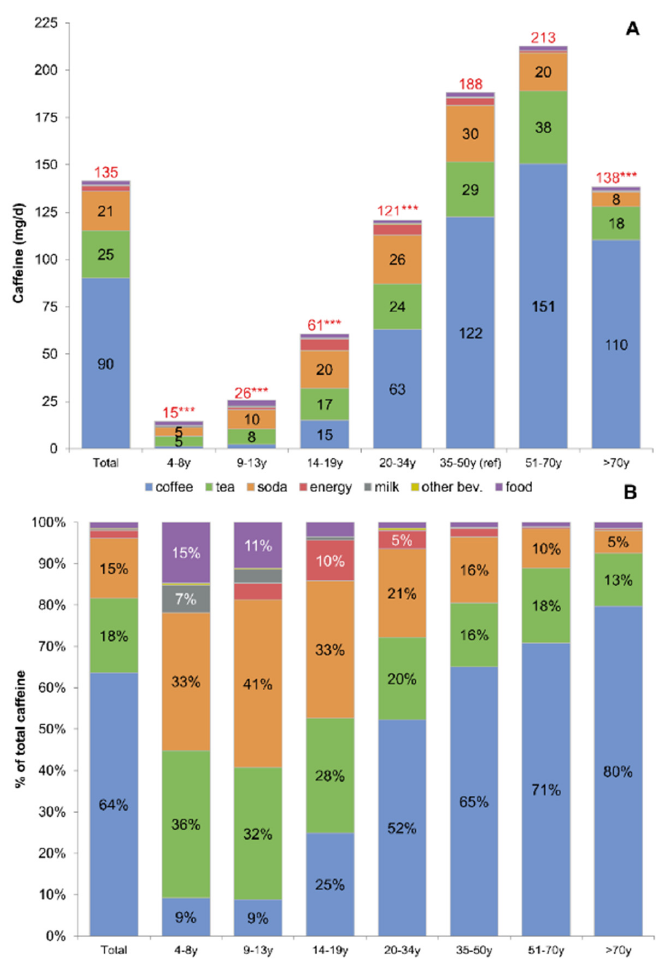
Figure 1. Absolute (( A ), mg/day) and proportional a (( B ), % of total) sources of caffeine from beverages and foods by age group, NHANES 2011–2012. Asterisks represent pairwise survey-weighted t -test with age 35–50 years as the reference group; *** p < 0.001; ** 0.001 < p <0.01; * 0.01 < p < 0.05. a Values less than 5% in Panel B are unlabeled, but include the following. For the total population, values were: energy drinks 2%, flavored milk 0.2%, other beverages 0.2%, and food 1.5%. For age 4–8 years, values were: energy drinks 0% and other beverages 0.5%). For age 9–13 years, values were: energy drinks 4.0%, flavored milk 3.3%, and other beverages 0.3%). For age 14–19 years, values were: flavored milk 0.8%, other beverages 0.1%, and food 3.4%. For age 20–34 years, values were: flavored milk 0.1%, other beverages 0.5%, and food 1.4%., For age 35–49 years, values were: flavored milk 0.1%, other beverages 0.5%, and food 1.4%. For age 51–70 years, values were: energy drinks 0.4%, flavored milk 0.1%, other beverages 0.1%, and food 1.0%. For age > 70 years, values were: energy drinks 0.3%, flavored milk 0.2%, other beverages 0.1%, and food